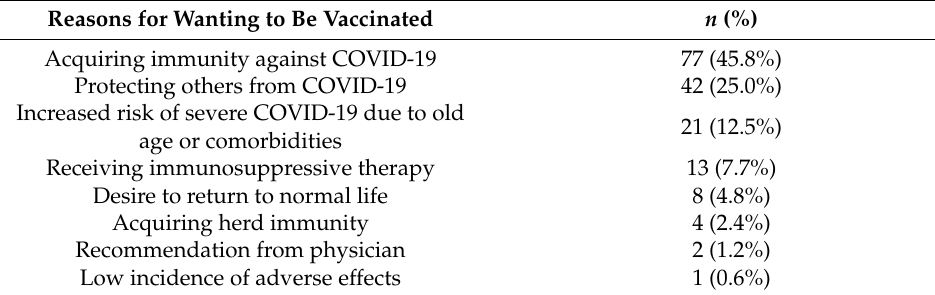
Table 4. Reasons for the acceptance of COVID-19